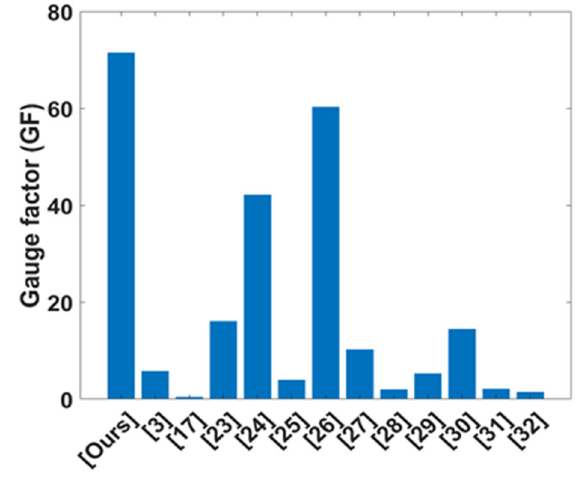
Figure 8. Comparison (GF) with other studies.